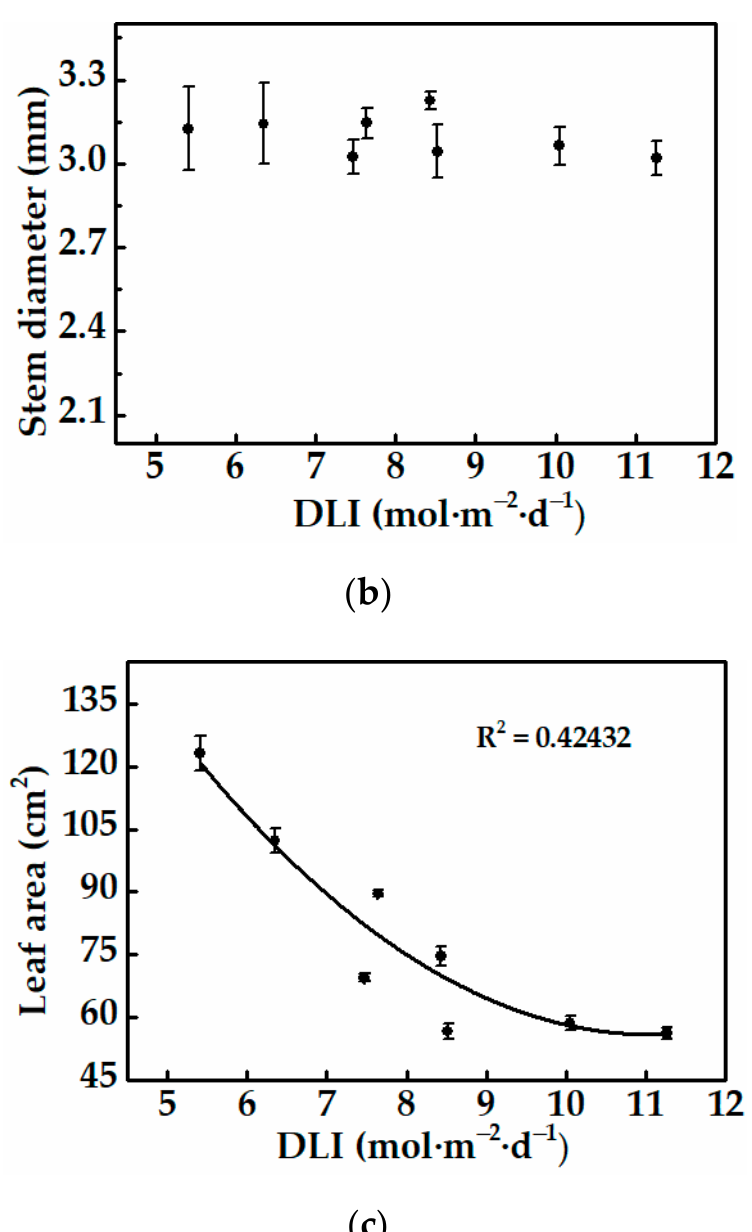
Figure 2. Relationships between DLI and ( a ) hypocotyl length, ( b ) stem diameter and ( c ) leaf area of cucumber seedlings. Each symbol represents the mean of 18 plants in each treatment, and error bars represent SEs of means. Fitting formula shown in supplementary section.